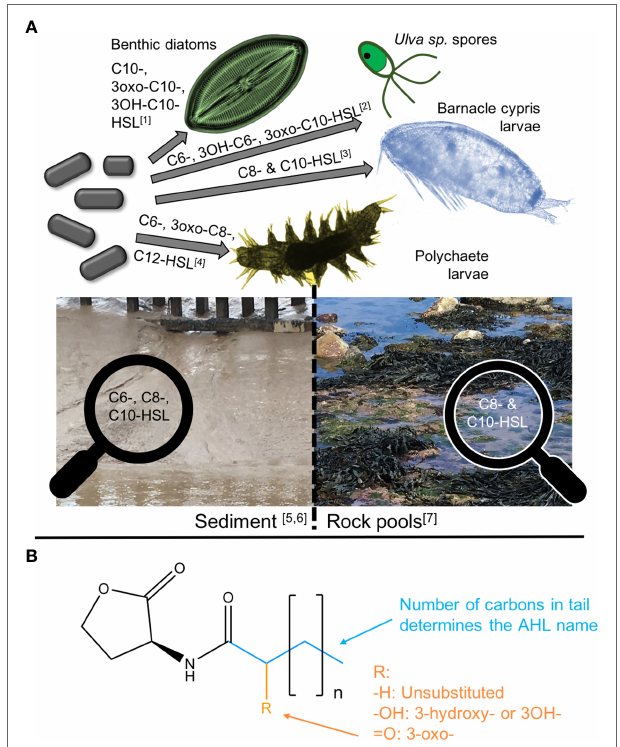
FIGURE 1 | Overview of AHL-mediated interactions, their presence in different environments and their basic chemical structure. (A) gives an overview of bacterial AHLs that are known to mediate interactions with selected algae and invertebrates, and indicates important AHLs for different marine habitats. (B) shows the basic structure of AHLs and explains the nomenclature with the number of carbons in the blue tail giving the name and the substitution at R in orange determining the AHL class. References: [1] Yang et al. (2016a), [2] Joint et al. (2007), [3] Tait and Havenhand (2013), [4] Huang et al. (2007), [5] Decho et al. (2009), [6] Stock et al. (2021) and [7] Tait et al. (2009). Barnacle larvae picture by Kent Berntsson taken from Larsson et al. (2016) and polychaete larvae picture taken from Wang et al